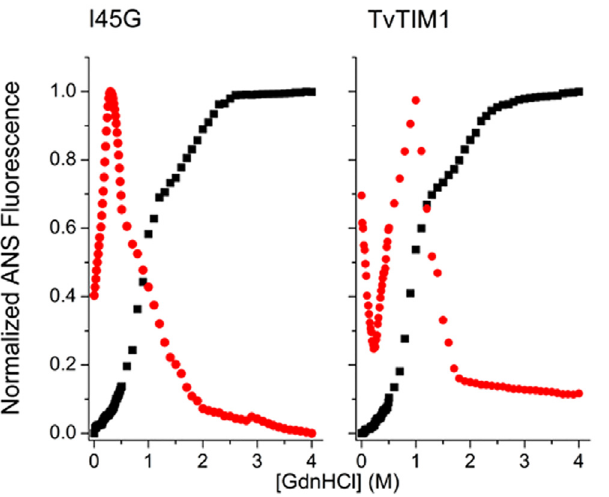
Fig 5. Unfolding profiles of TvTIM1 and I45G mutant monitored by Intrinsic (black squares) and ANS (red circles) fluorescence . The conditions are as described for Fig 4. The protein concentration was 50 μ g ml -1 . Data are normalized for ease of